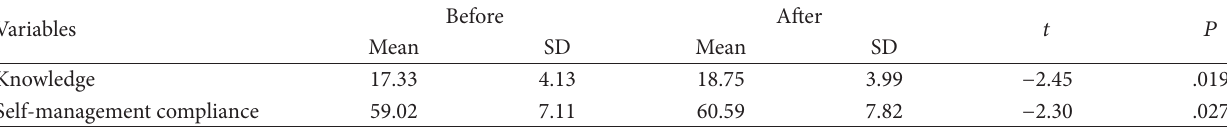
T 4: Comparison of knowledge and self-management compliance before and aer application of the online program